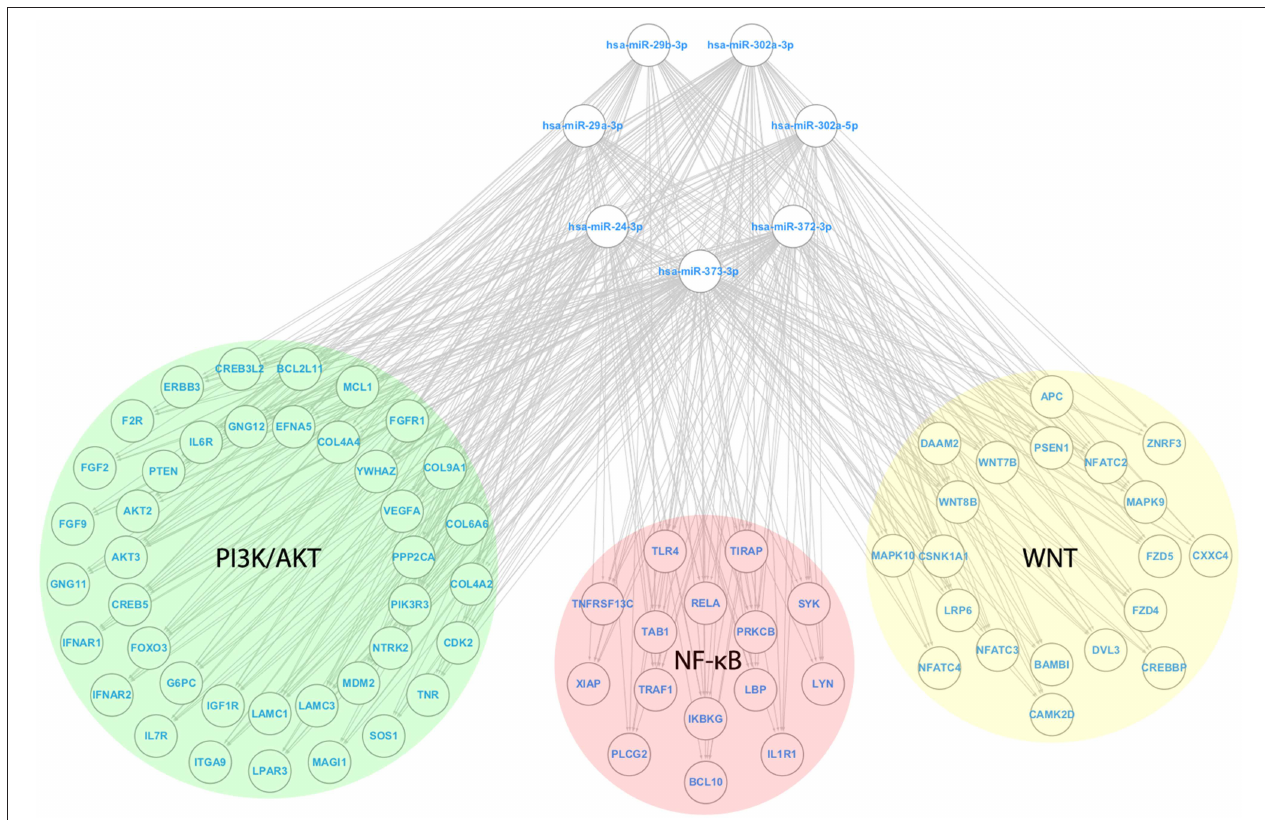
FIGURE 6 | MicroRNA Regulatory network with miRs from the anti-survival/EMT group. A microRNA regulatory network was composed of miRs from the anti-survival/EMT group, along with their targets from the PI3K/AKT (Green circle), NF- κ B (Red circle), and Wnt (Yellow circle) signaling pathways. For each pathway, targets from the outer portion of the circle are the ones targeted by no more than 5 miRs, whereas the ones from the inside portion of the circle are the ones targeted by more than 5 miRs (maximum of 7). The following genes are shared between the signaling pathways NF- κ B and PI3K/AKT: IKBKG , RELA , SYK, and TLR4 ; NF- κ B and WNT: PRKCB